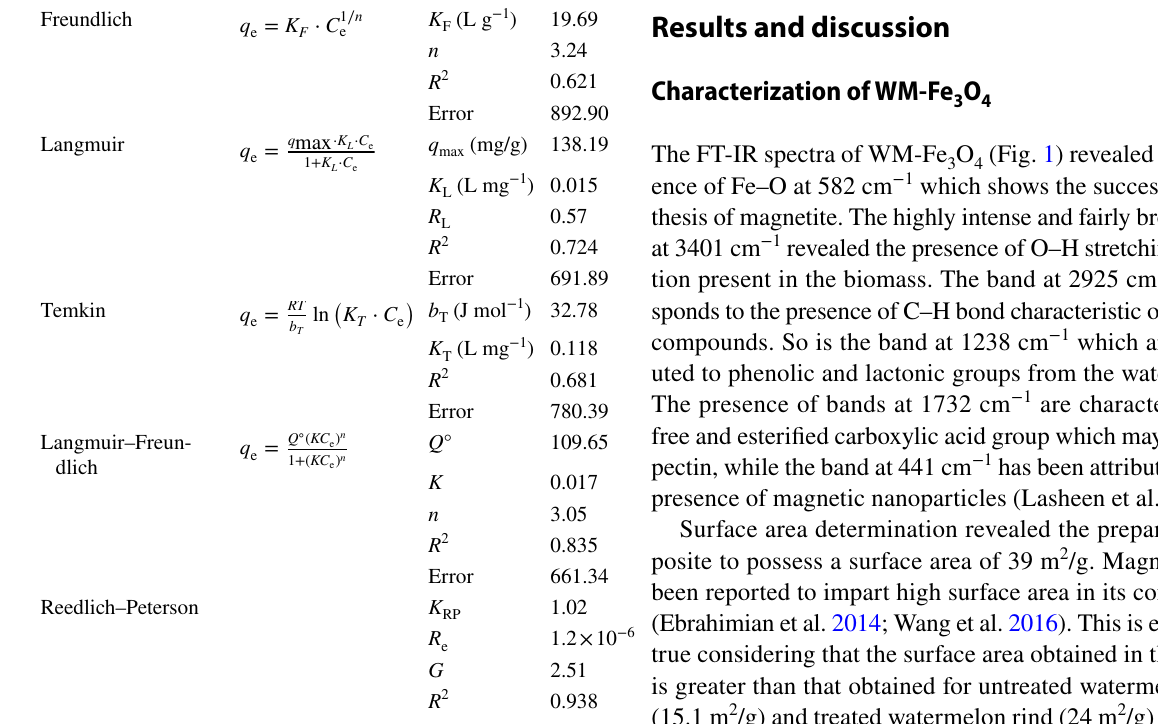
Table 1 Adsorption isotherm model parameters for the adsorption of Pb 2+ on WM-Fe 3 O 4 Model